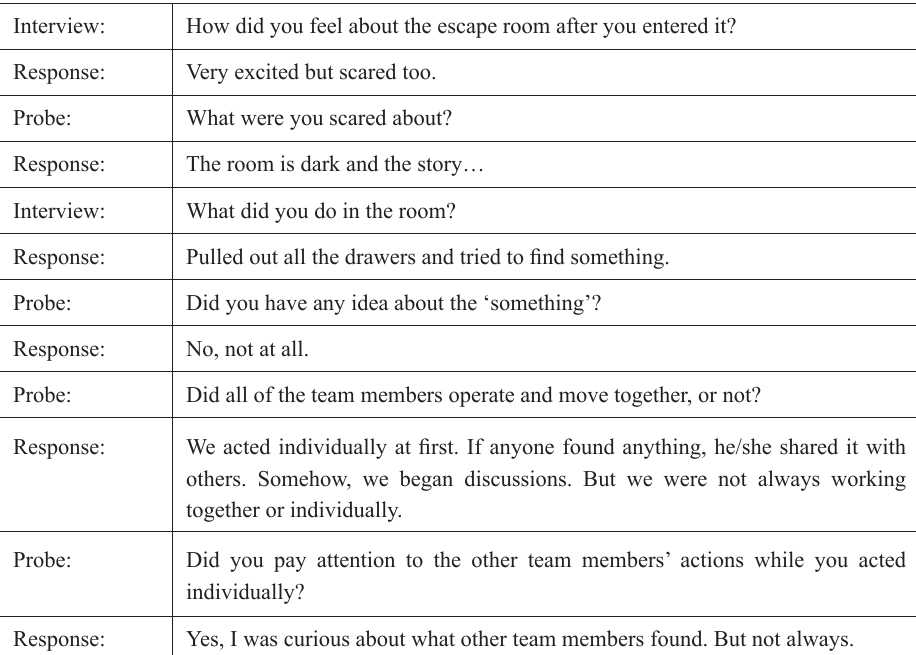
Table 3. Sample raw data of interview questions, subsequent probes and responses